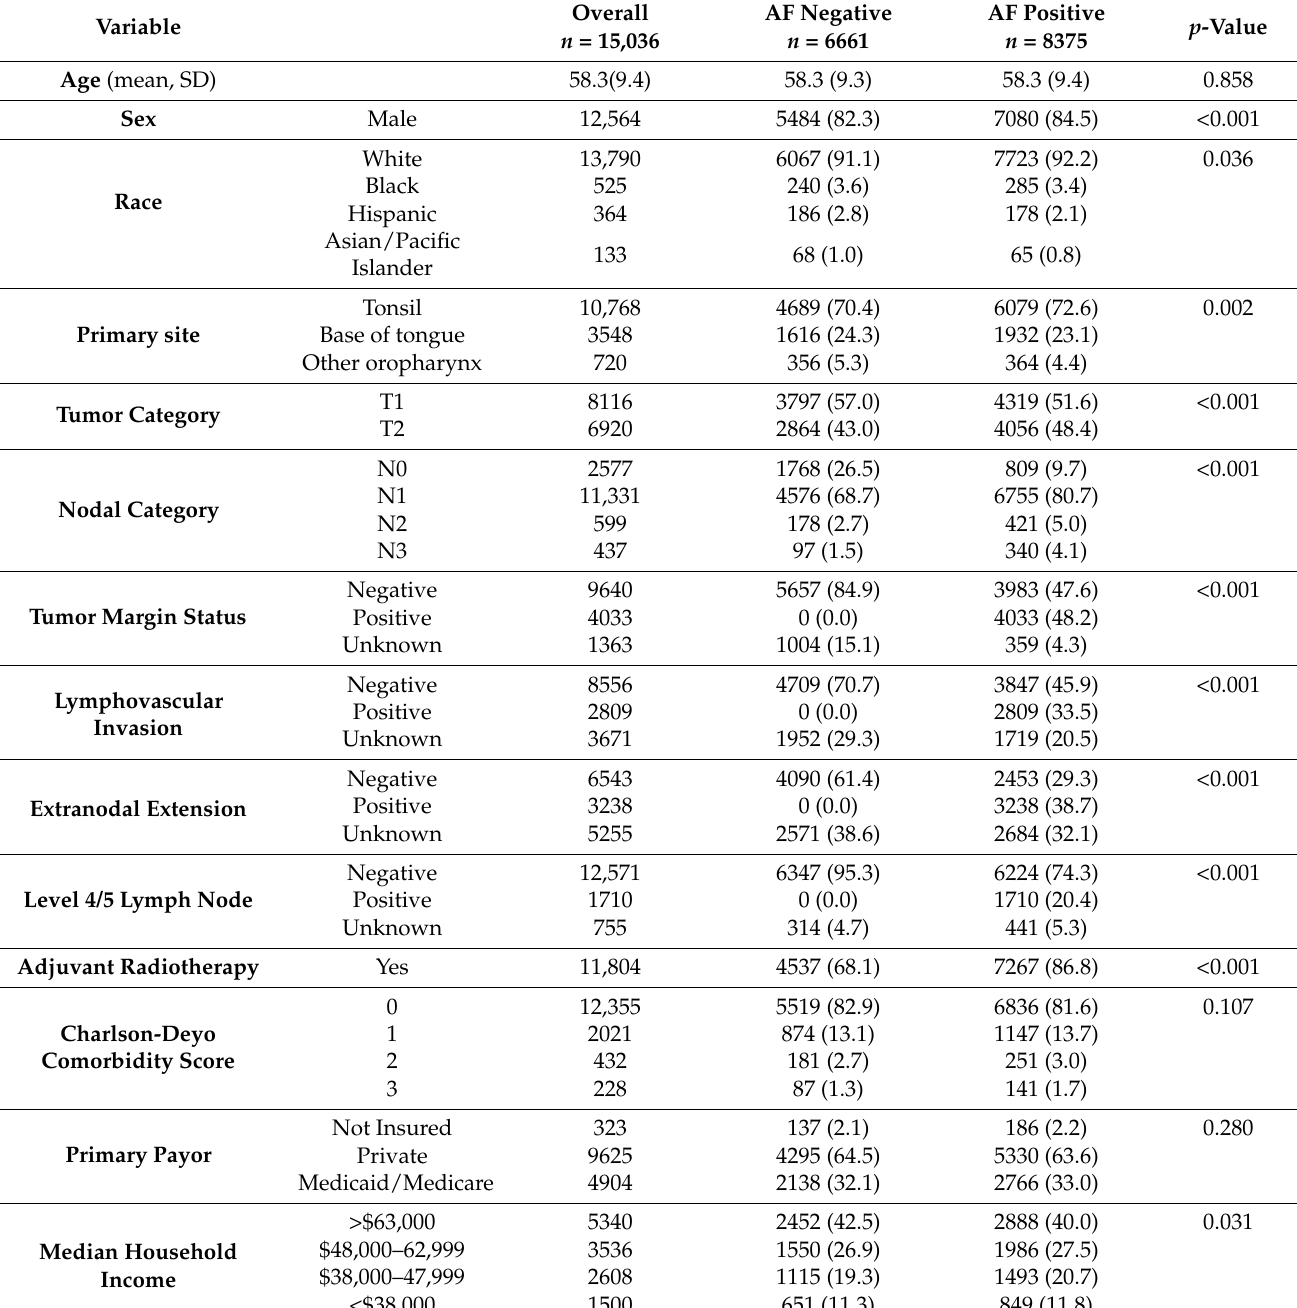
Table 1. Baseline Characteristics by Adverse Feature